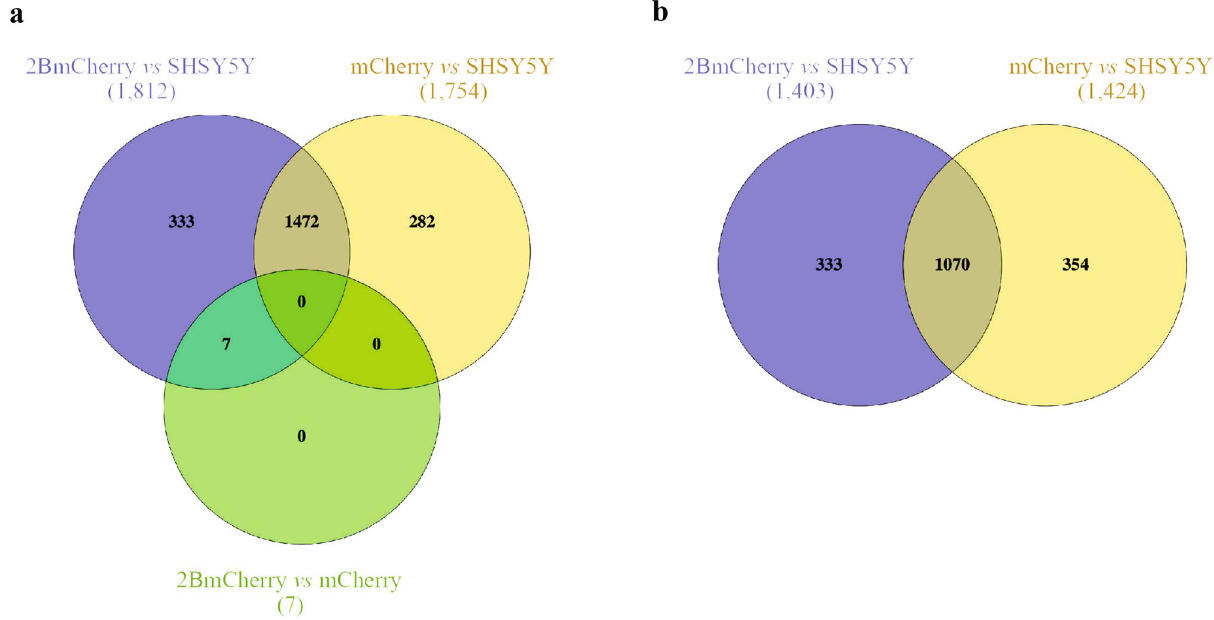
Figure 3. Venn diagrams of upregulated ( a ) and downregulated ( b ) DEGs among the three comparison groups (2BmCherry versus SHSY5Y, mCherry versus SHSY5Y, and 2BmCherry versus mCherry). The numbers in the overlap areas indicate the common DEGs found in the compared transcriptomes. The numbers in the non- overlap areas indicate the unique DEGs of the respective